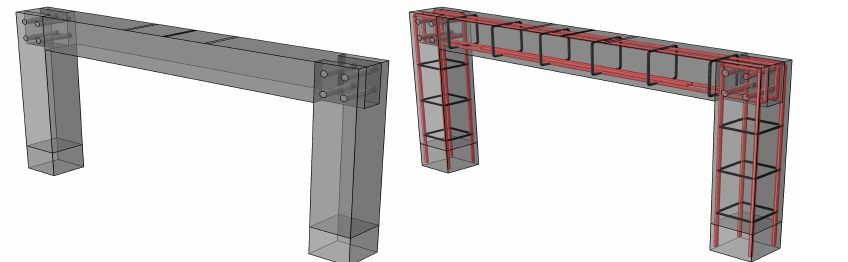
Figure 19. F8, Rebar layout and geometrical dimensions.